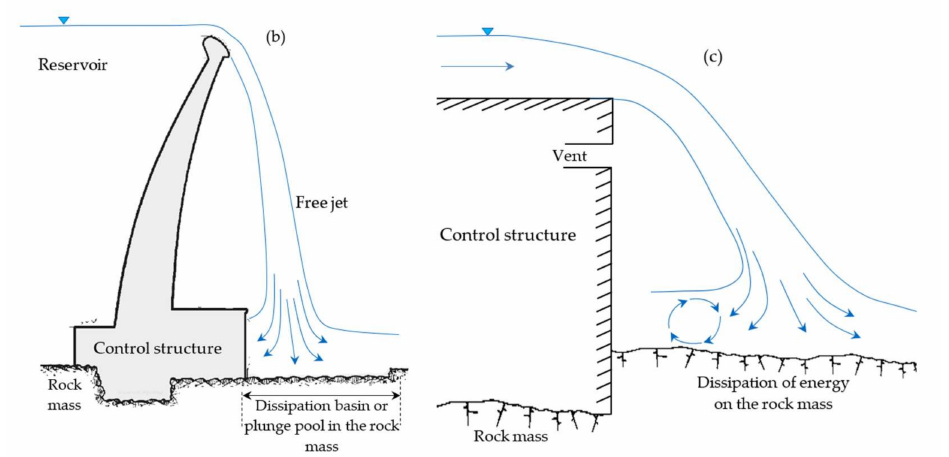
Figure 4. Types of spillways. ( a ) Typical longitudinal section through an unlined spillway of a large embankment dam; ( b ) schematic representation of a free jet, and ( c ) schematic representation of discharge over a drop